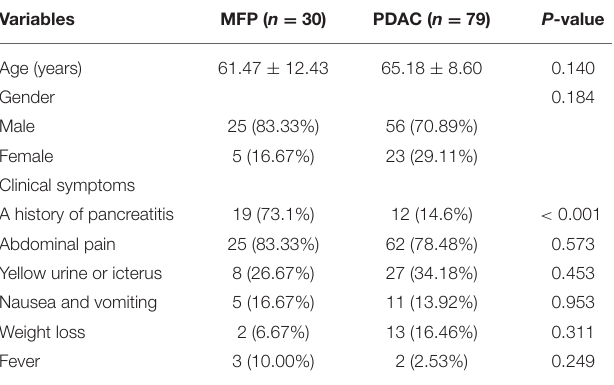
TABLE 1 | Clinical data of patients with MFP and PDAC.